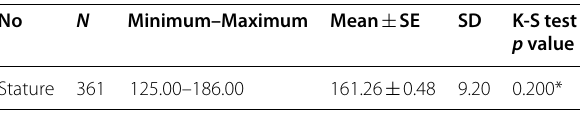
Unit in centimetre (cm) * p > 0.05